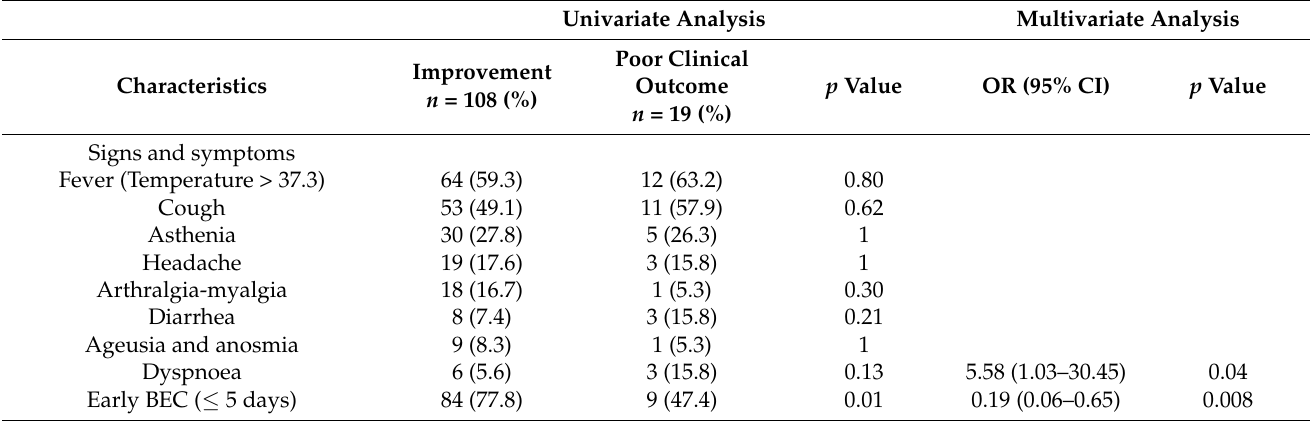
Table 3. Cont. Univariate Analysis Multivariate